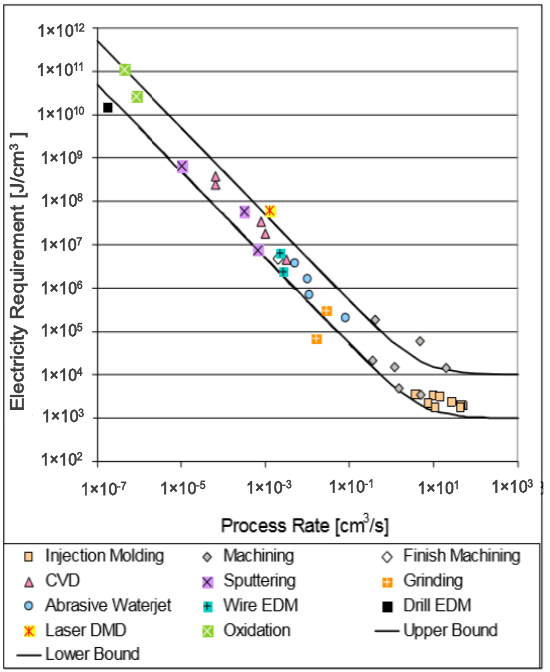
Figure 3. Specific electricity requirements for various manufacturing processes as a function of the rate of material processed [47].